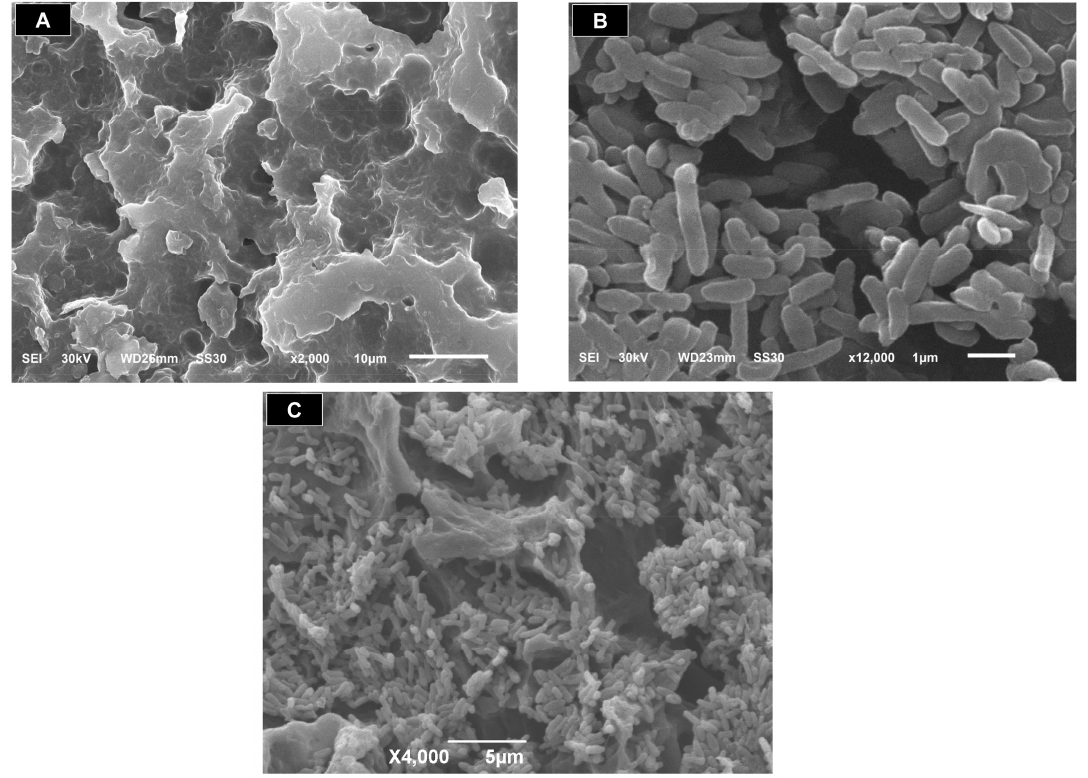
Figure 2. Representative SEM micrograph of the aCTS-MBs ( A ), P. putida MB285 cells ( B ) and the bacCTS-MB1 complex ( C ).